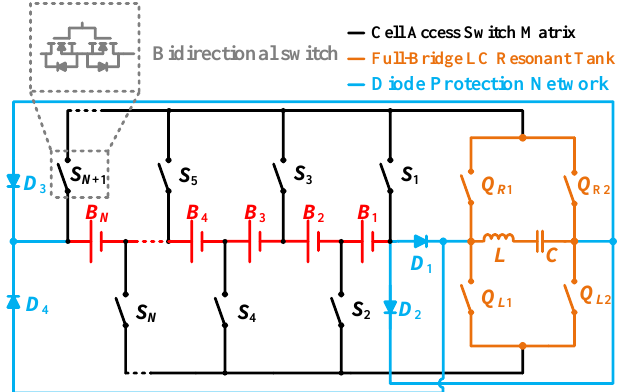
Figure 1. Proposed FBBRLCC equalizer for N cells.